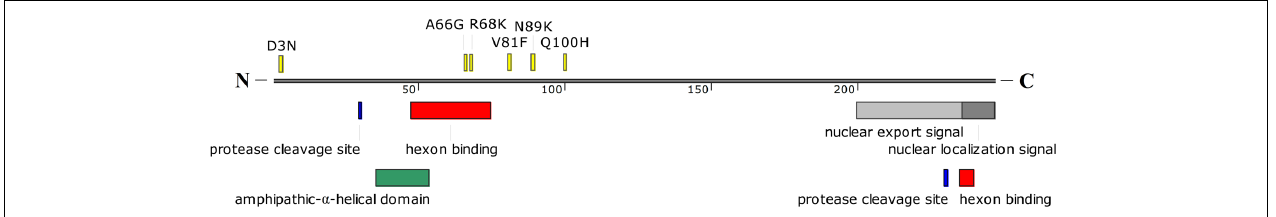
FIGURE 4 | Schematic representation of HAdV-B55 protein VI. The amino acid mutations between HAdV-B55 strains BJ01 and QS-DLL are indicated in yellow. Sites for cleavage by the protease, nuclear export signal, and nuclear localization signal are also indicated in different colors. The hexon binding domains are located between amino acid residues 48 to 74 and 235 to 239. A predicted amphipathic- α -helical domain is also shown. The location of these domains was estimated from the previous report by Wiethoff et al. (2005). TABLE 5 | Comparative genomics analysis of two HAdV-B55 strains: QS-DLL and BJ01. Region Position Mutation in DNA Substitution in protein